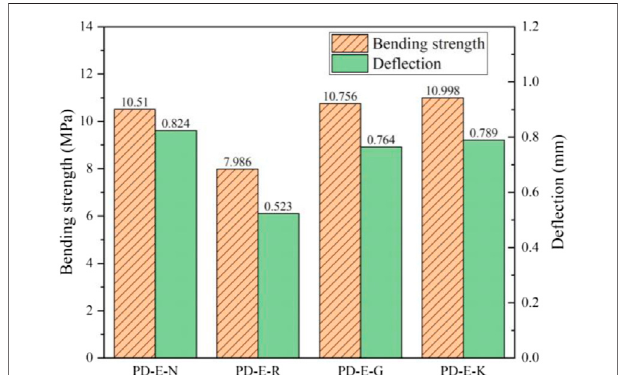
FIGURE 6 | Interfacial parameters comparison.